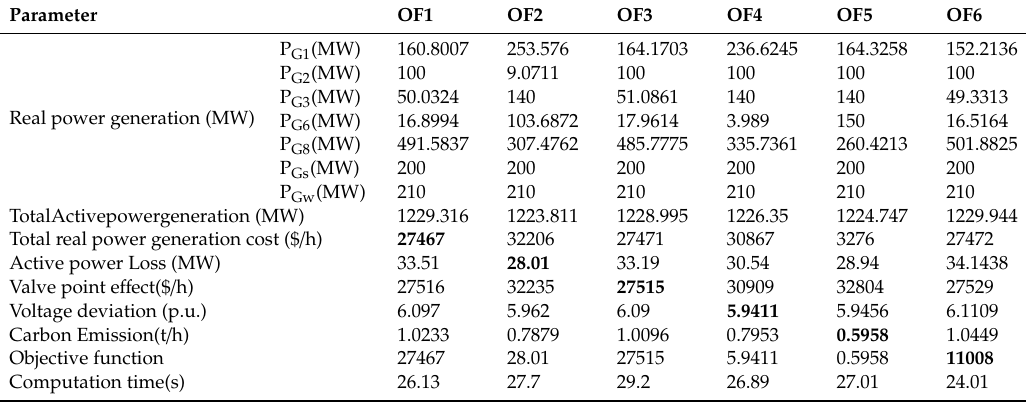
Table 9. Optimal power flow solution with contingency using GWO.